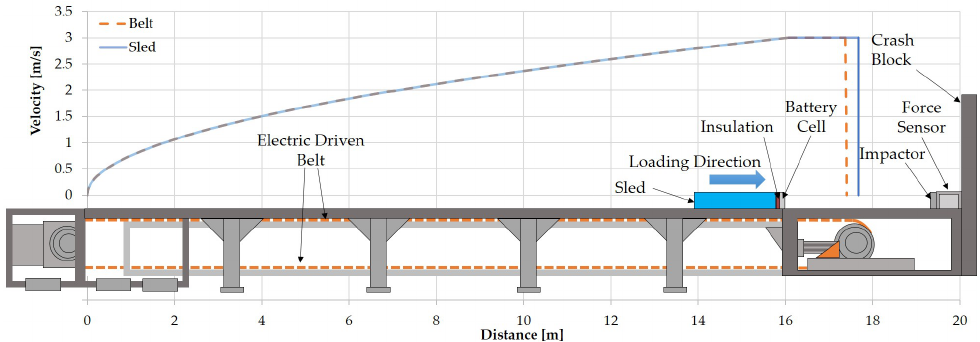
Figure 3. Illustration of the ELLMAR test rig with movable sled used for dynamic cell tests at 3000mm/s in this